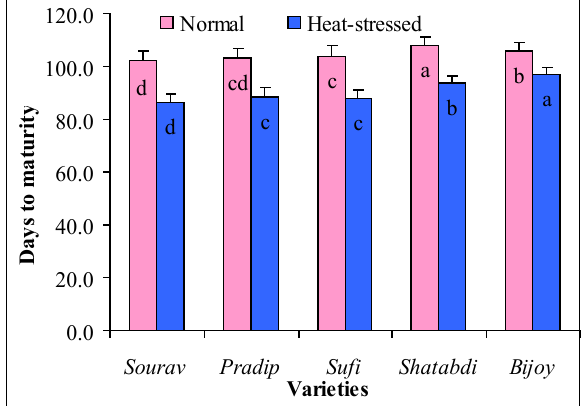
Fig. 5. Days to maturity of different wheat varieties under nor- mal and heat stressed condition. Mean (±SD) was calculated from three replicates for each treatment. Bars with different let- ters are significantly different at P < 0.05 applying LSD